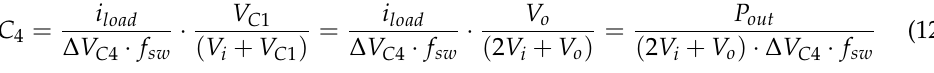
Taking into account the expressions given by (5) and (6), the converter static voltage gain of each output and capacitor voltages can be obtained, which are given by: